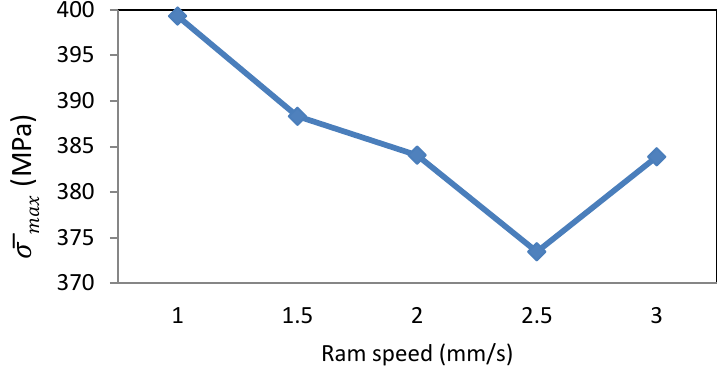
Figure 11. Influence of the ram speed on the core maximum effective stress (T = 200 °C).